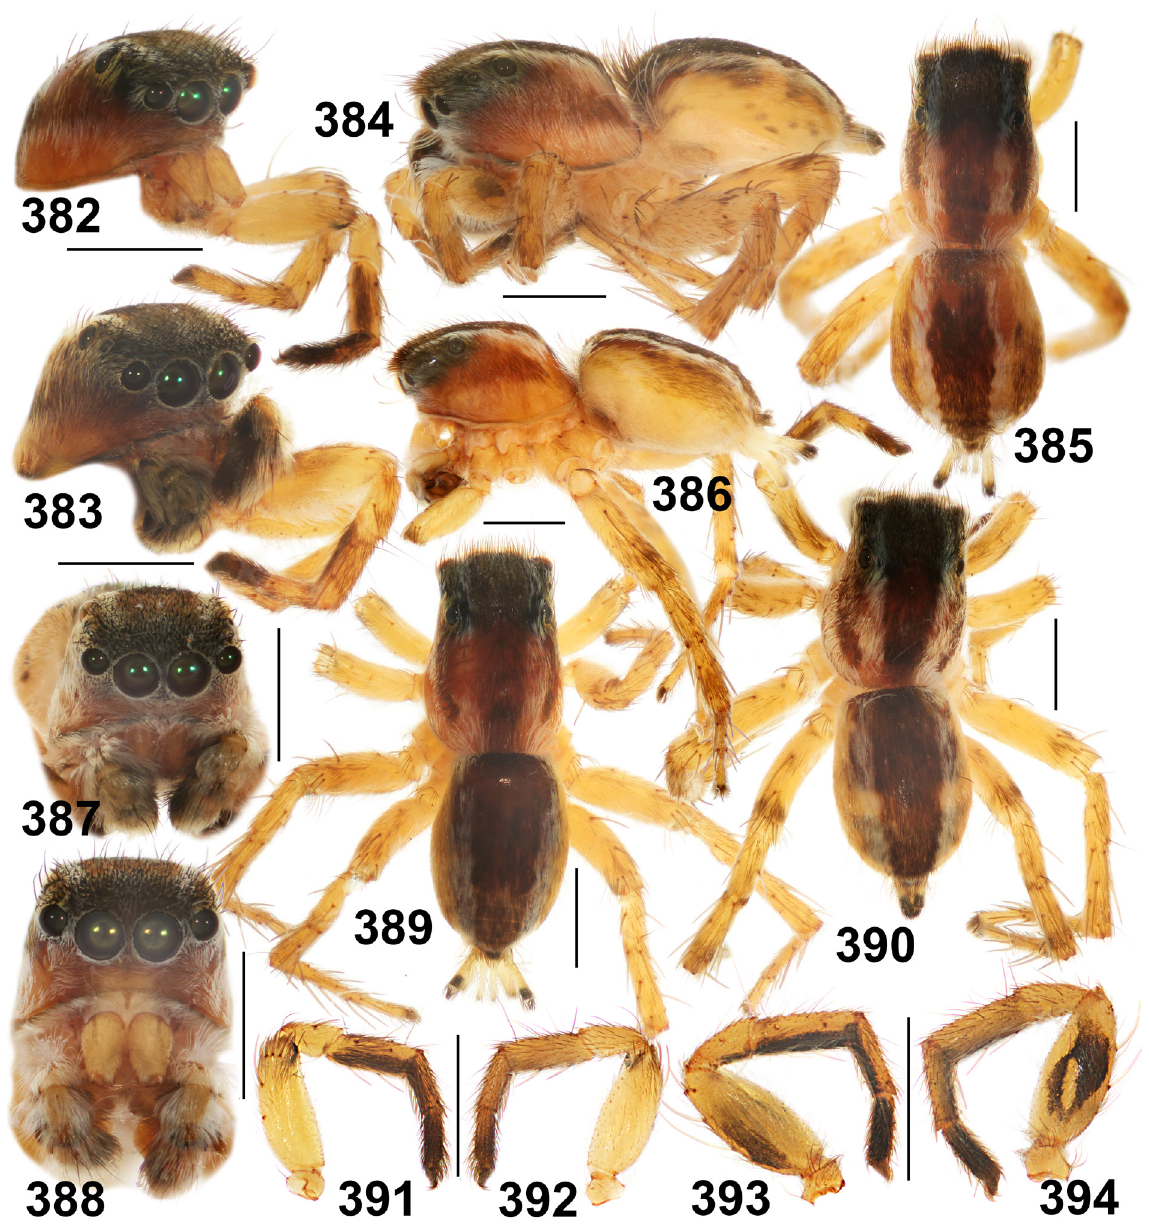
Figs 382–394. Stenaelurillus nigricaudus Simon, 1886 , ♂♂. 382–390 . General appearance. 391 , 393 . Legs 1, prolaterally. 392 , 394 . Legs 1, retrolaterally. Specimens: 382, 385–386, 388–389, 391– 392 from Burkina Faso; 383–384, 387, 390, 393–394 from Senegal (Richard Toll). Scale bars: